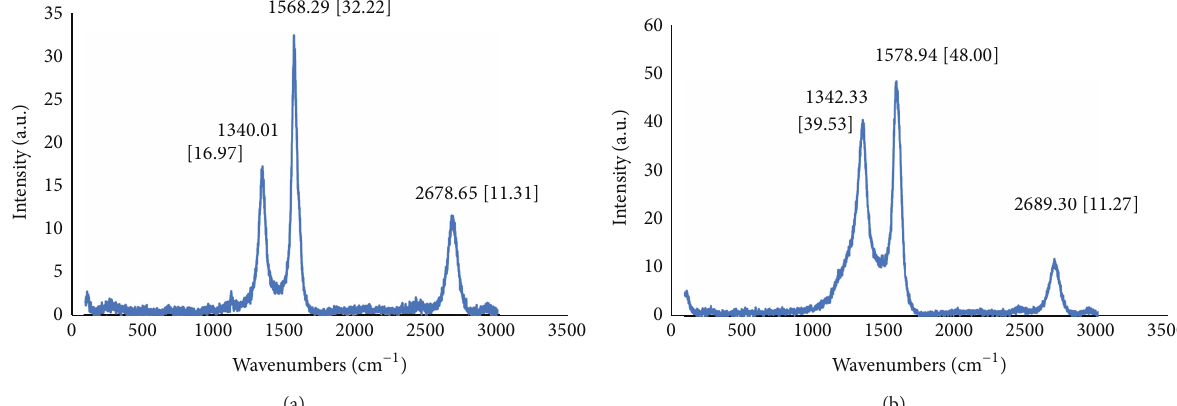
Figure 1: Raman spectra of nanomaterial synthesized from Fe/Co on (a) magnesium oxide and (b) calcium carbonate as support material.